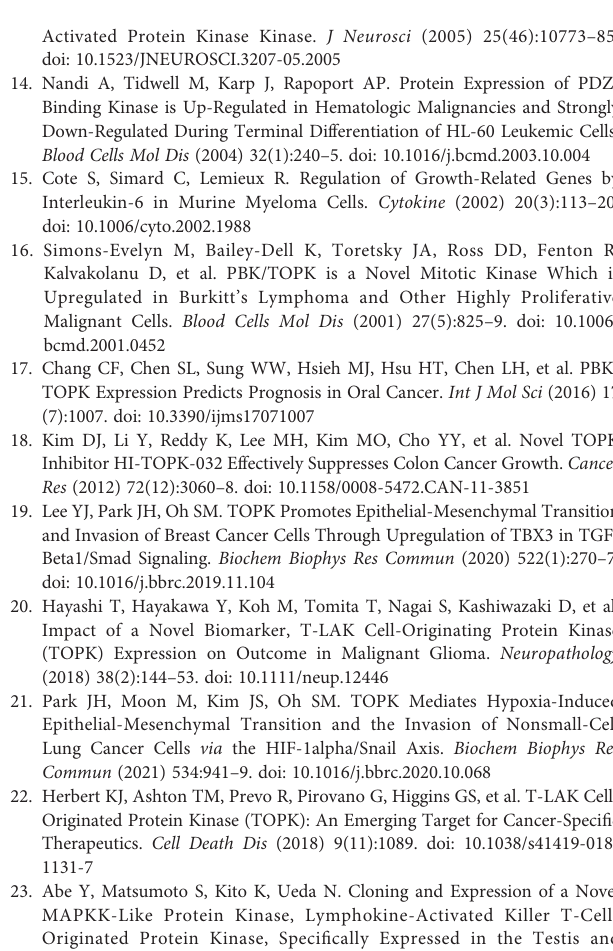
Supplementary Figure 1 | GO and KEGG enrichment analysis. (A) GO enrichment analysis of up-regulated genes. (B) GO enrichment analysis of down- regulated genes. Thetopten GO terms werepresented from the aspects ofBP, CC and MF. (C) KEGG pathway enrichment analysis of up-regulated genes. (D) KEGG pathway enrichment analysis of down-regulated genes. Supplementary Figure 2 | HI-TOPK-032 up-regulated Bax expression but down-regulated Bcl-2 expression in pituitary cells. (A) Expression of Bax in MMQ cells. (B) Expression of Bax in GH3 cells. (C) Expression of Bcl-2 in MMQ cells. (D) Expression of Bcl-2 in GH3